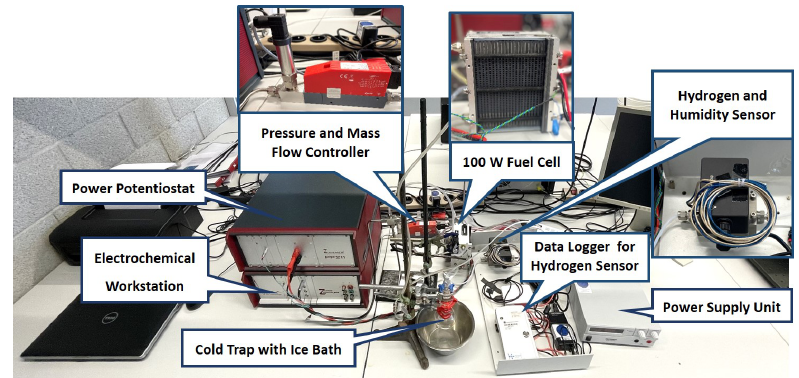
Figure 6. Photograph of the used fuel cell stack test setup.